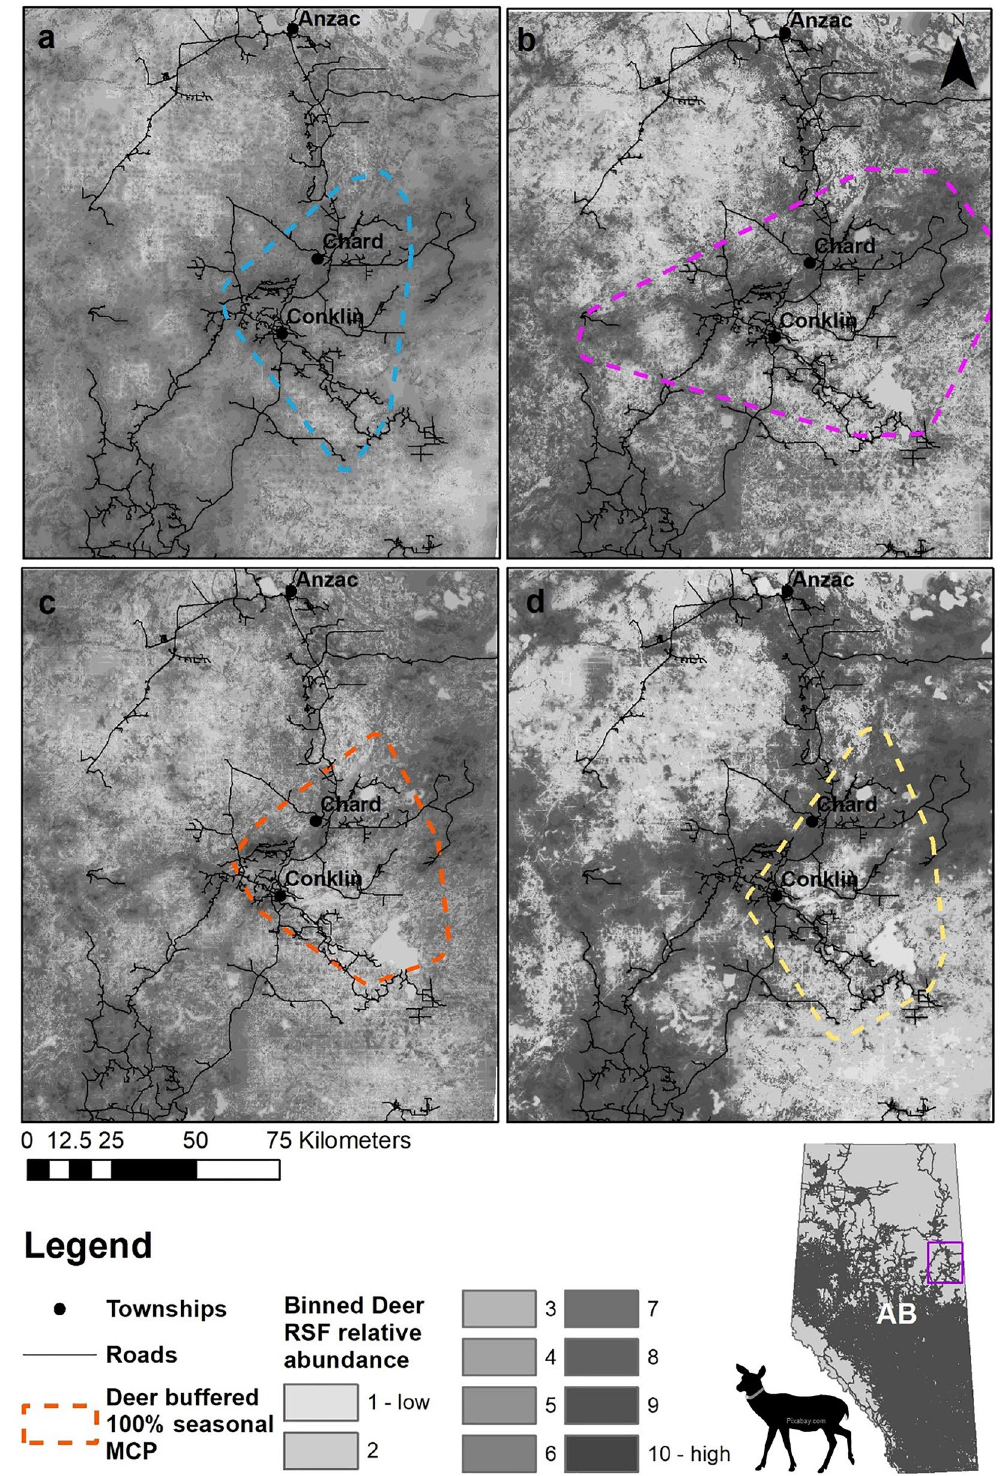
Figure 2. Binned seasonal white-tailed deer population level Resource Selection Function (RSF) relative abundance estimates near Conklin, Alberta Canada with overlaid road network and buffered 100% MCP for ( a ) Winter (cyan) ( b ) Parturition (magenta) ( c ) Summer (red) and ( d ) Rut (yellow) for combined years from 2012 to 2014. Data are spatially extrapolated to extend < 50 km from MCP